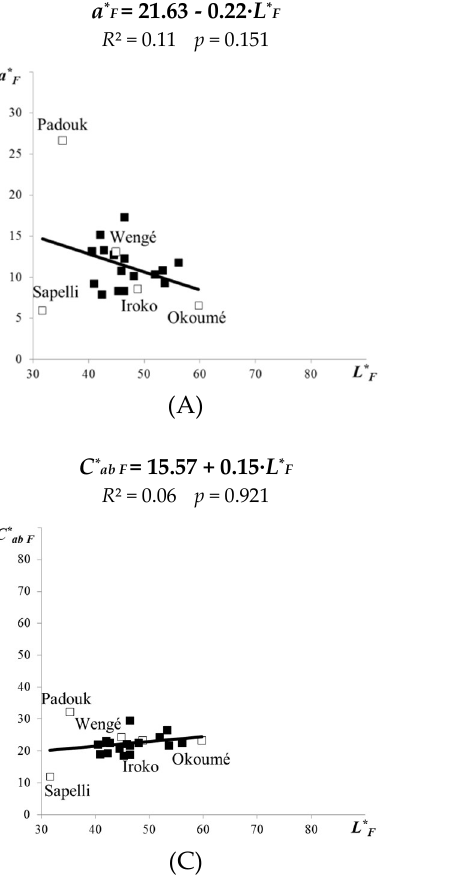
Figure 4. Linear correlations between the lightness L * and the colour coordinates a * , b * ( A, B ), the colour saturation C *ab ( C ), and the hue tone angle h ab ( D )—for 21 tropical wood species attacked by the brown-rot fungus C. puteana.